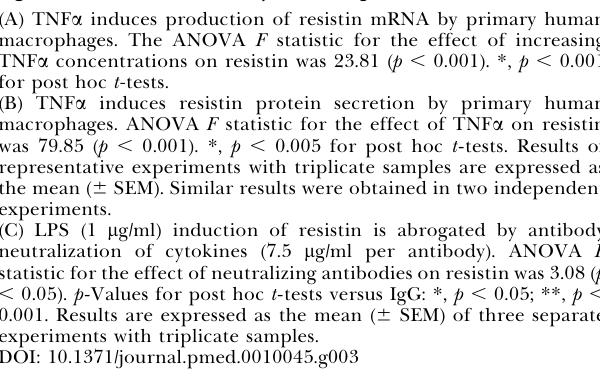
mouse peritoneal macrophages harvested after thioglycolate treatment did not express detectable levels of mouse resistin, even after treatment with LPS (data not shown).